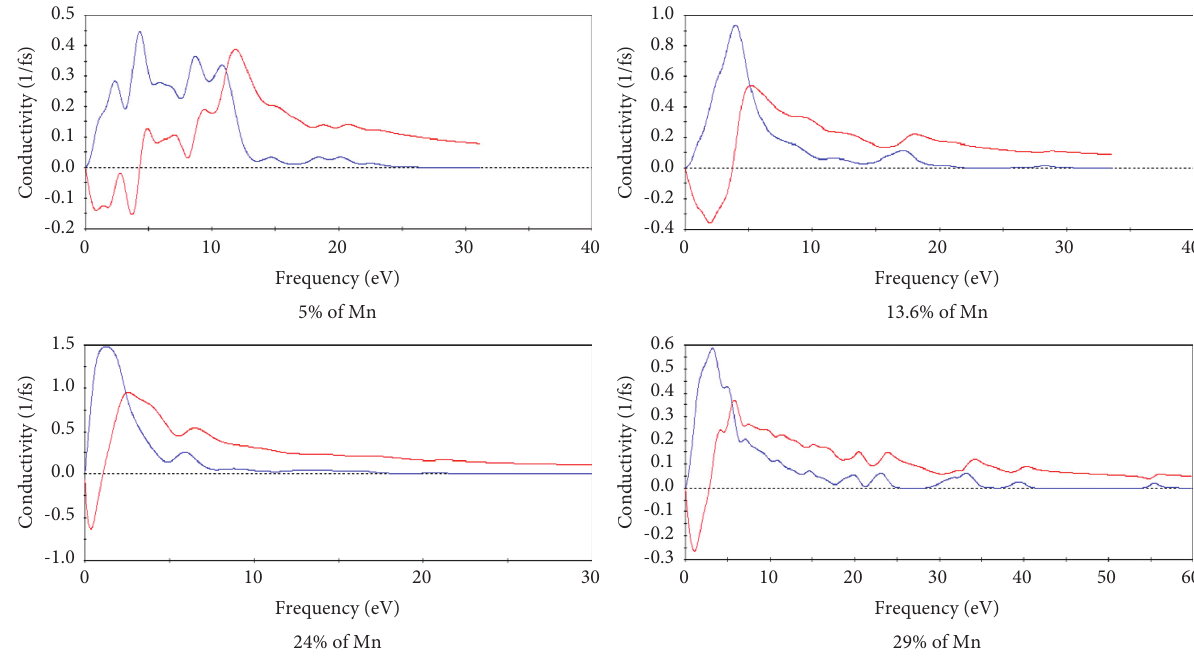
Figure 4: The conductivity of InSb–Mn with Mn � 5%, Mn � 13.6%, Mn � 24%, and Mn � 29%. Table 1: The band gap of InSb–Mn with Mn � 5%, Mn � 13.6%, Mn � 24%, and Mn � 29%. Concentration of